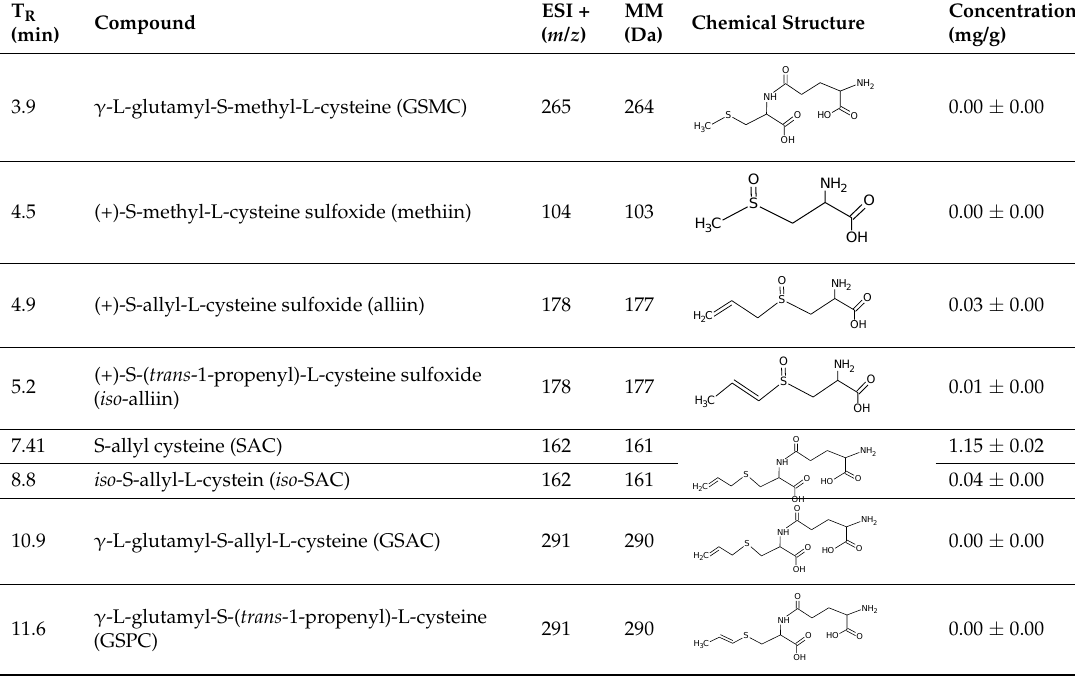
Figure 1. UV-Vis spectra of ABG10+® in water solution ( A ) and HPLC-PAD chromatogram of the S- allyl cysteine (Retention time (R T ): 11.58 min) in ABG10+® ( B ).